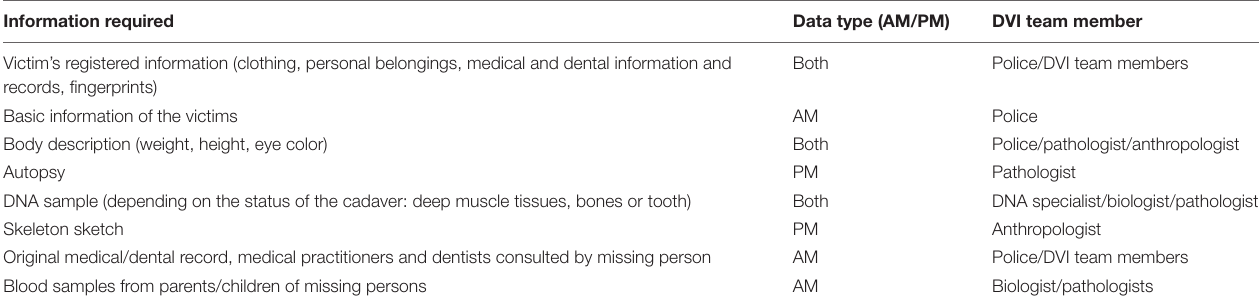
TABLE 1 | Classification of information requirements for DVI teams, type of information, and forensic specialist responsible for its collection. Information